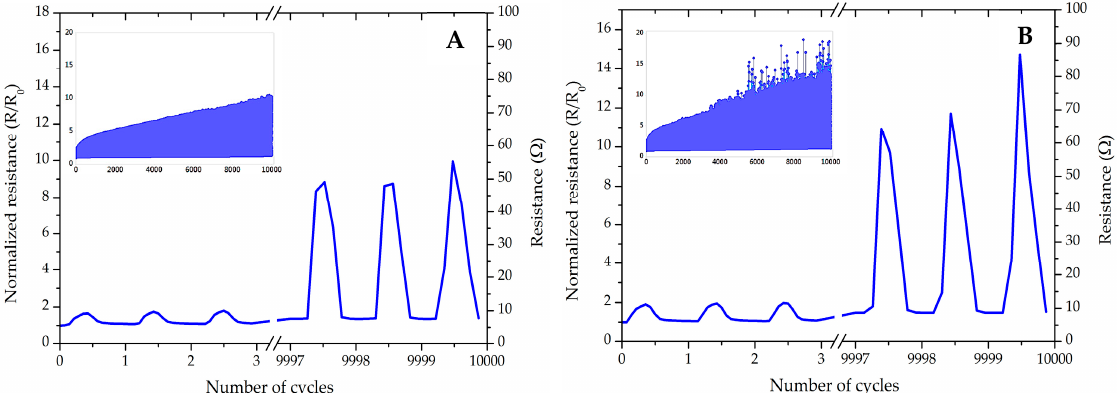
Figure 10. The normalized/normalized resistances during 10,000 cycles at 10% stretching. ( A ) Partially TPU ‐ covered, R 0: 5.4 Ω . ( B ) Entirely TPU ‐ covered, R 0 : 6.1 Ω . The insets are the overall trend during all the cycles.